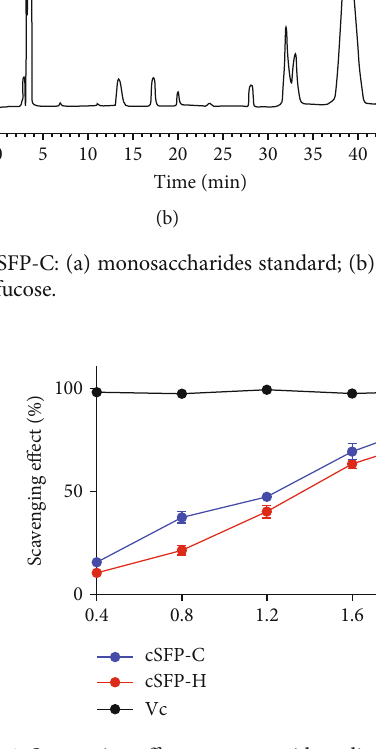
Figure 4: Scavenging e ff ect on superoxide radicals by cSFP-C and cSFP-H. Values are means ± S : D : ( n = 3